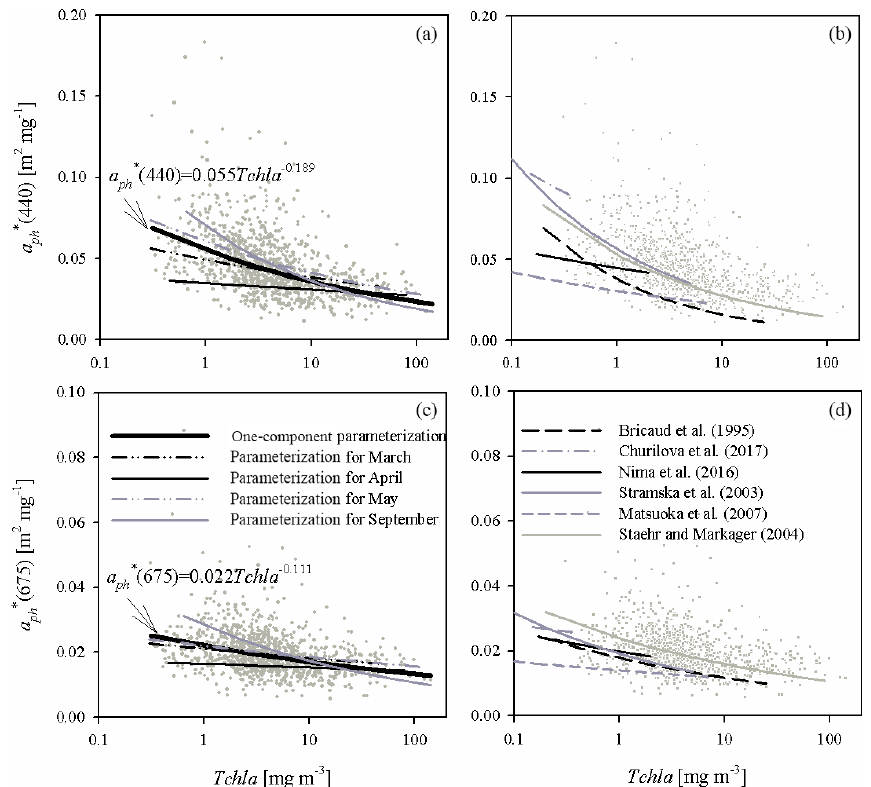
Figure 6. (a) Relationship between coefficient a ∗ (440) and the chlorophyll a concentration Tchl a and its functional approximations ph determined in this study for all the data analysed and for selected sampling months (the legend is given in c ; the equation given in the panel represents approximations of all the data available; for coefficients obtained for particular months, see Table A2 in Appendix A); (c) as in (a) but for a ∗ (675); (b, d) plots similar to (a, c) but presenting examples of functional approximations determined by various authors (the ph legend is given in d ). The grey dots in each panel represent individual data points from our